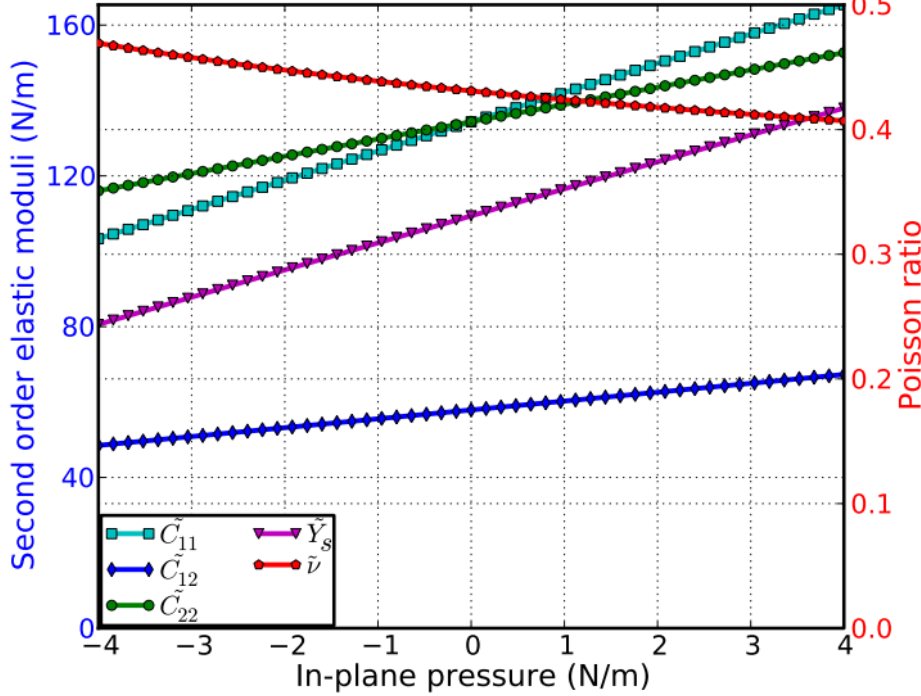
Figure 16. Second- order elastic moduli and Poisson’s ratio as a function of the pressure. Figure 16. Second-order elastic moduli and Poisson’s ratio as a function of the